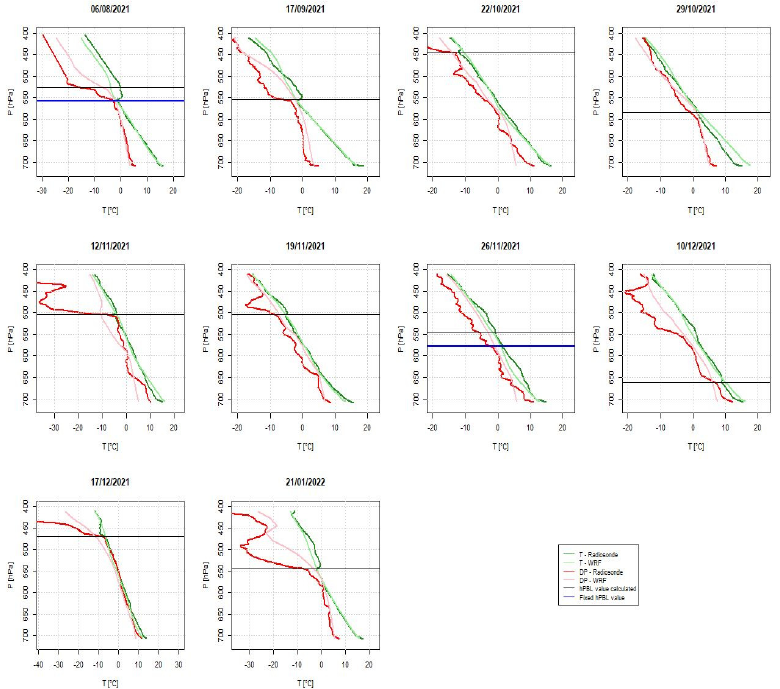
Figure 10. Temperature and dewpoint temperature pressure profiles from radiosonde and WRF with the calculated hPBL value for ten measurement events.